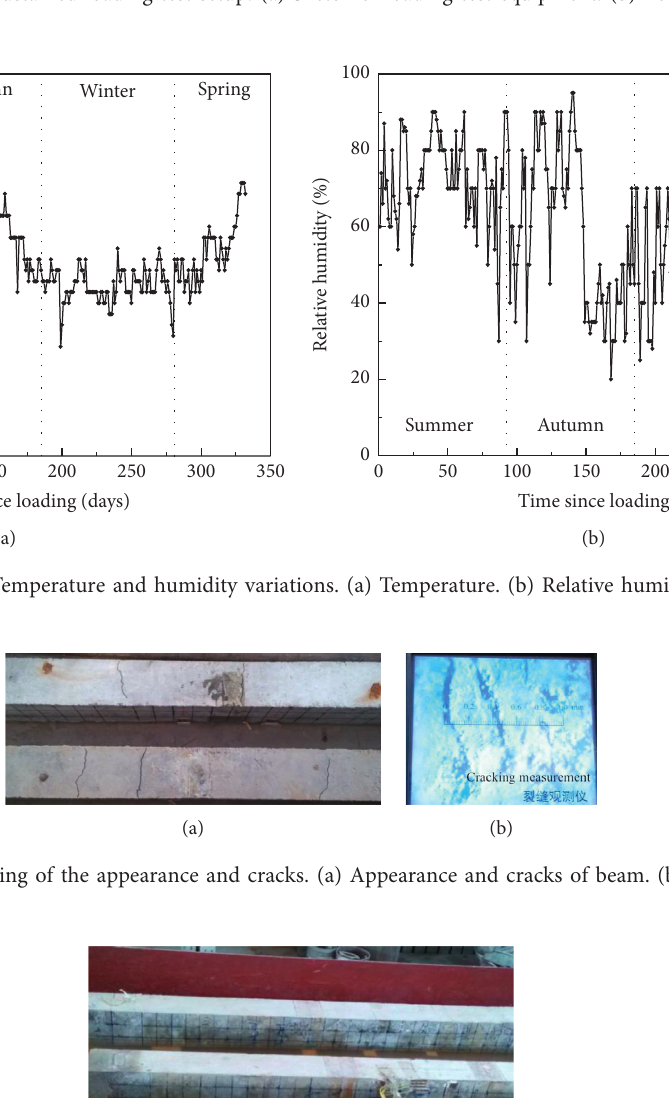
Figure 2: Schematic of the sustained loading test setup. (a) Sketch of loading test equipment. (b) Loading test equipment.